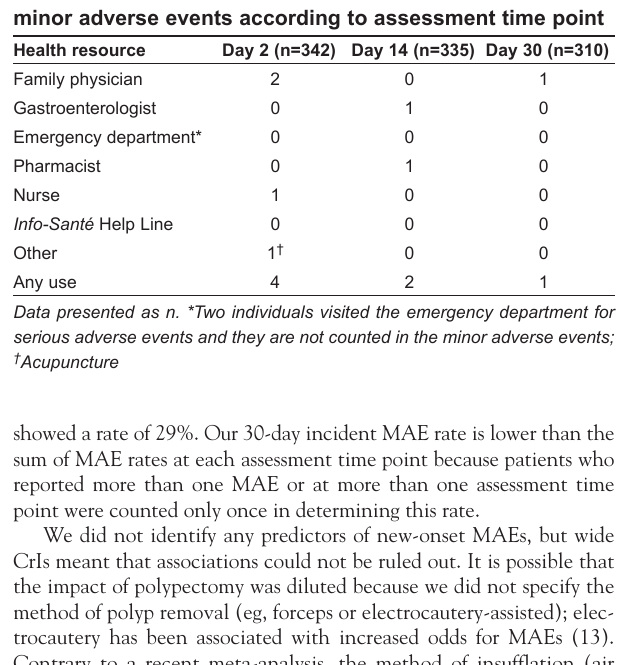
TAblE 2 Frequency of incident* minor adverse events reported